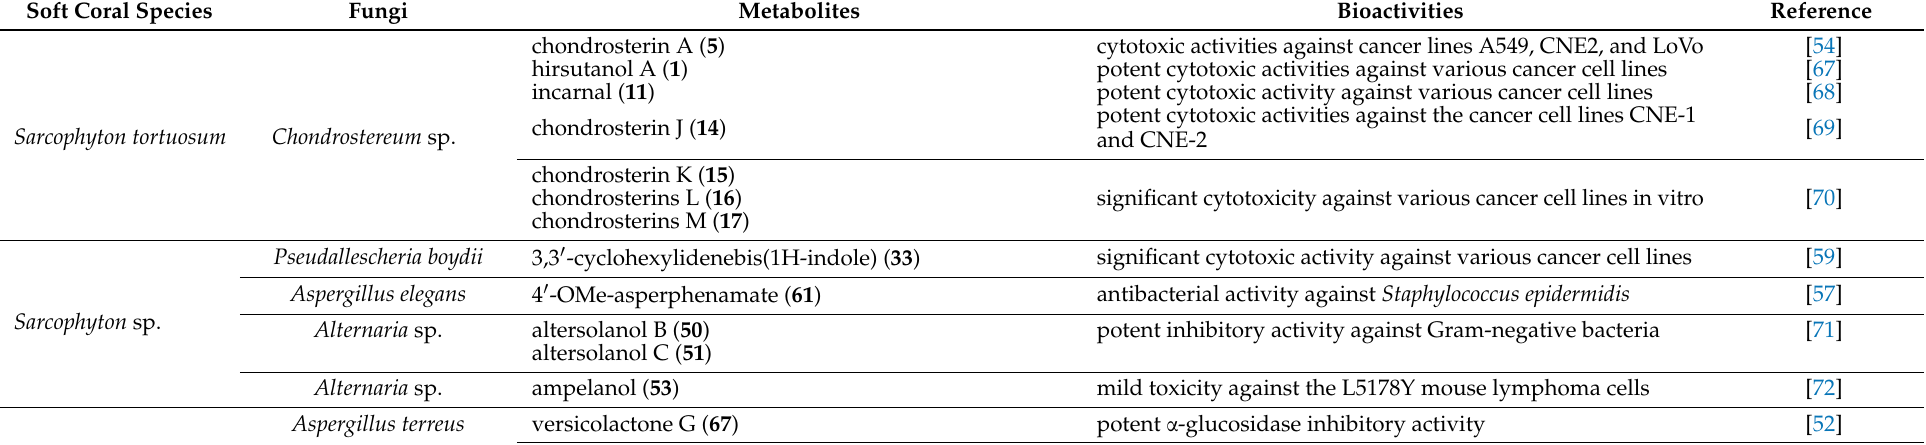
Table 3. Bioactivity of soft-coral associated marine